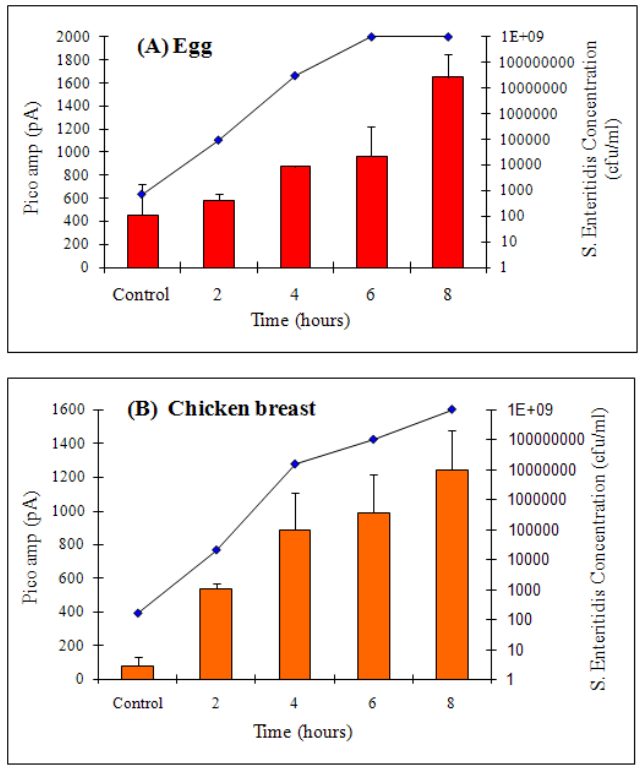
the biosensor. Line (growth curve) represents concentrations (right Y axis) of S . Enteritidis grown in egg suspended in TSB (A) and chicken breast (25 g in 225 mL TSB) (B). A total of 5-eggs were used for this experiment, one egg was used for each time